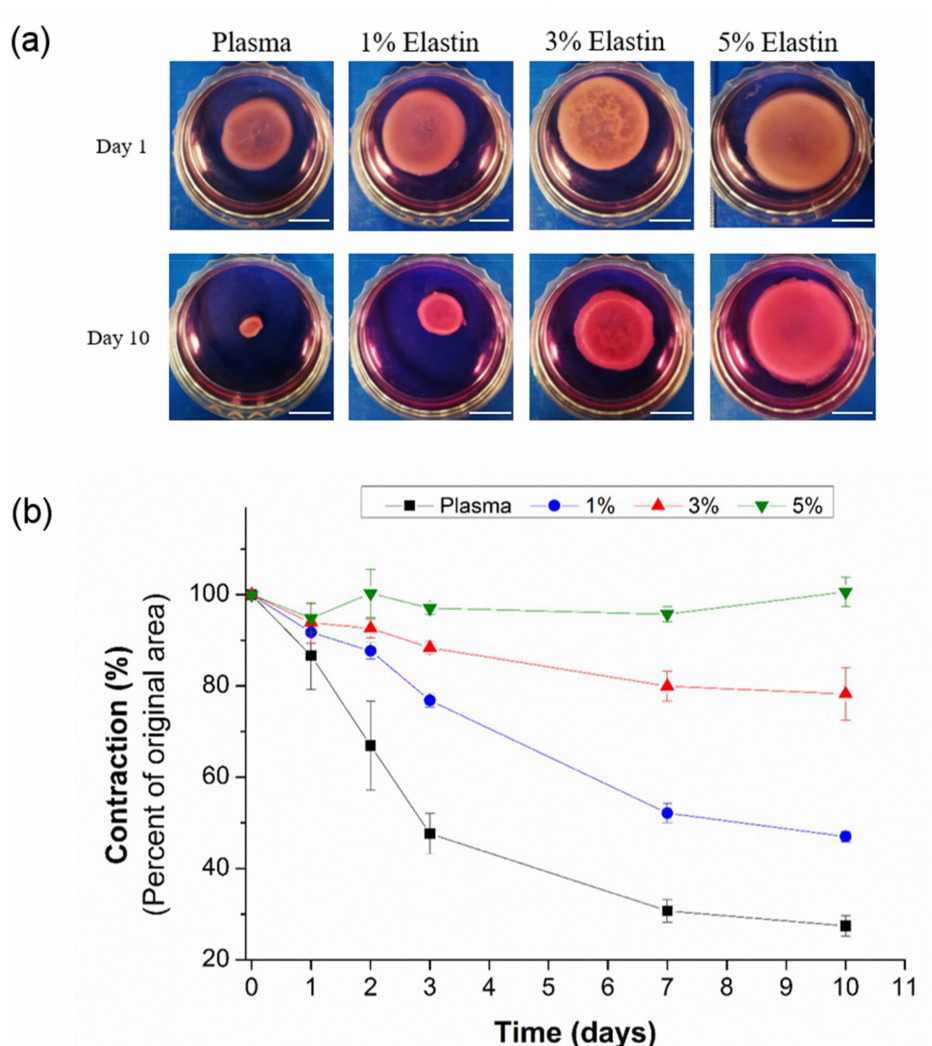
Figure 5. ( a ) Images of each gel composition in culture medium at time points 1 and 10 days. Percentages indicate % of elastin in elastin-plasma hydrogels. The scale bars correspond to 1 cm. ( b ) Cell-induced hydrogel contraction ratio for each hydrogel composition (n = 3), in culture medium at 37 ◦ C. Data reported as mean ± SD. Percentages indicate % w / v elastin content in plasma